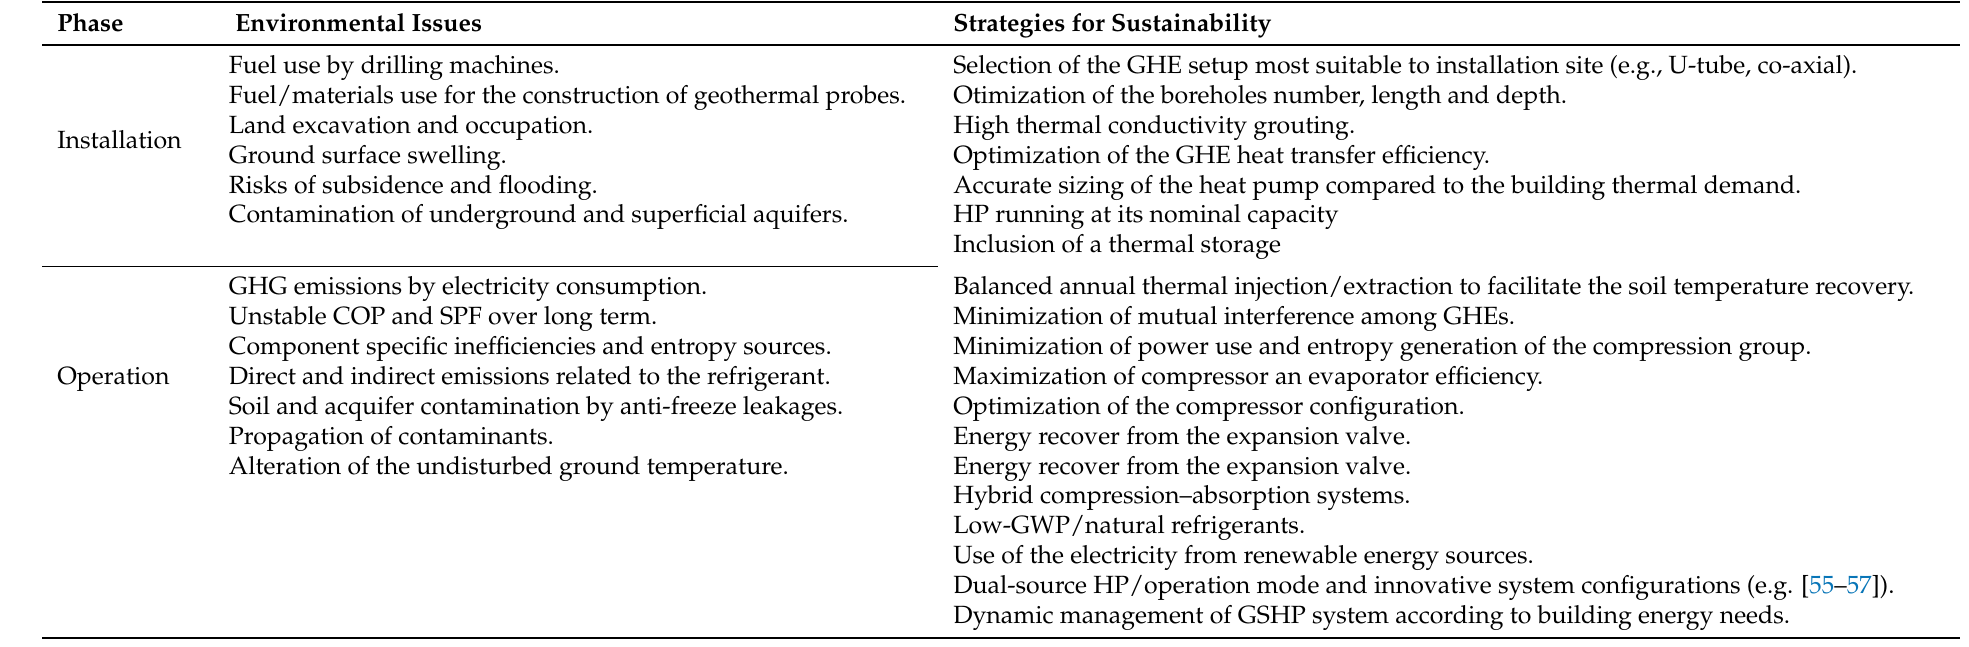
Table 1. The environmental issues distinguished by installation and operation phases and the strategies for enhancing the sustainability of geothermal heat